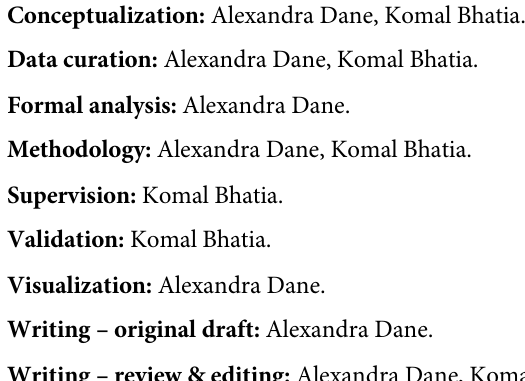
S4 Table. Adapted version of the Joanna Briggs Institute tool for quasi-experimental